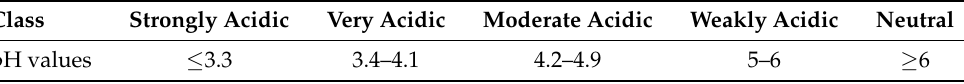
Table 2. Classes and corresponding pH values, (modified from Schulze and Kopp (2013) [8]). Class